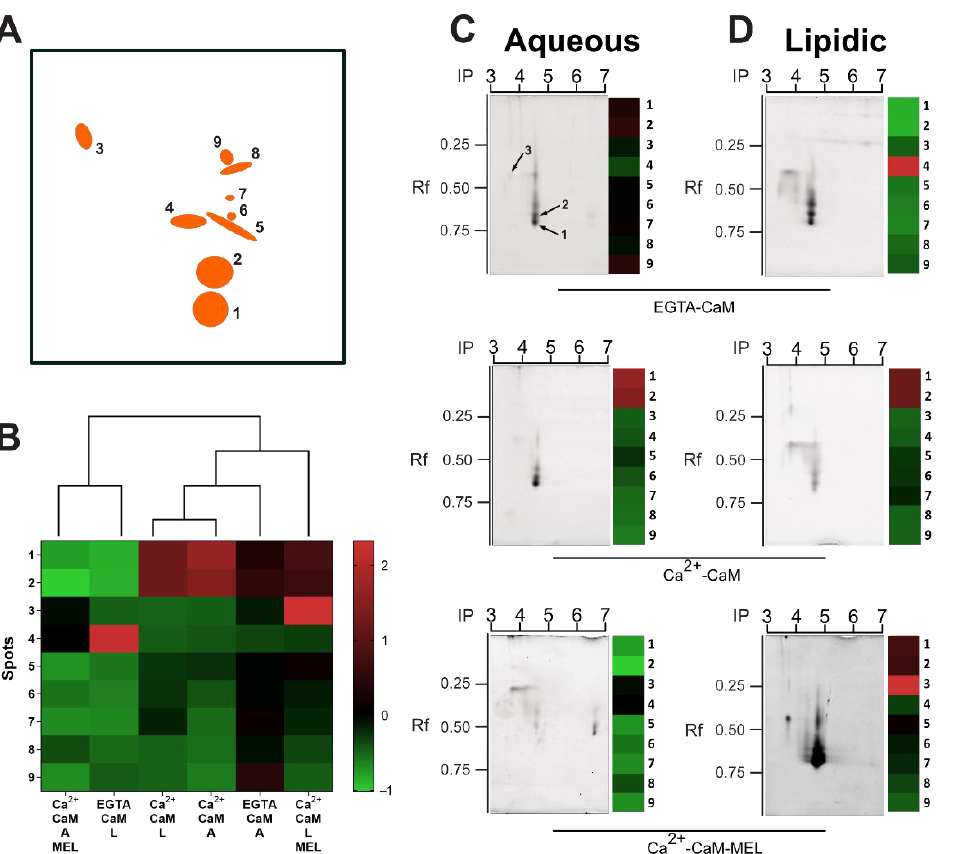
Figure 3. Calmodulin separation by native 2D electrophoresis. Calmodulin (CaM) was incubated with calcium (Ca 2+ -CaM), or with EGTA (EGTA-CaM), in presence of the vehicle (VEH) or with 10 − 7 M melatonin (MEL) in either aqueous or lipidic buffers for 10 min. CaM was detected by SYPRO ® Ruby stain and gels were run at least 2 times. ( A ) Significant spot summary of CaM conformations formed in a lipid or aqueous microenvironment are shown. ( B ) Results of the spot differences between the experimental groups are shown in the heatmap as Z-scores (standard deviation of the global mean), zero means no changes with respect to the mean of spots within the master gel. Representative images of CaM separated by 2D gel electrophoresis are shown. ( C ) Spot conformations of CaM in aqueous solution. ( D ) Spot conformations of CaM in lipidic solution. A: aqueous or L: lipidic buffers. Data were analyzed by a one-way ANOVA test and a Bonferroni multiple comparisons test. Significant differences were considered with p <